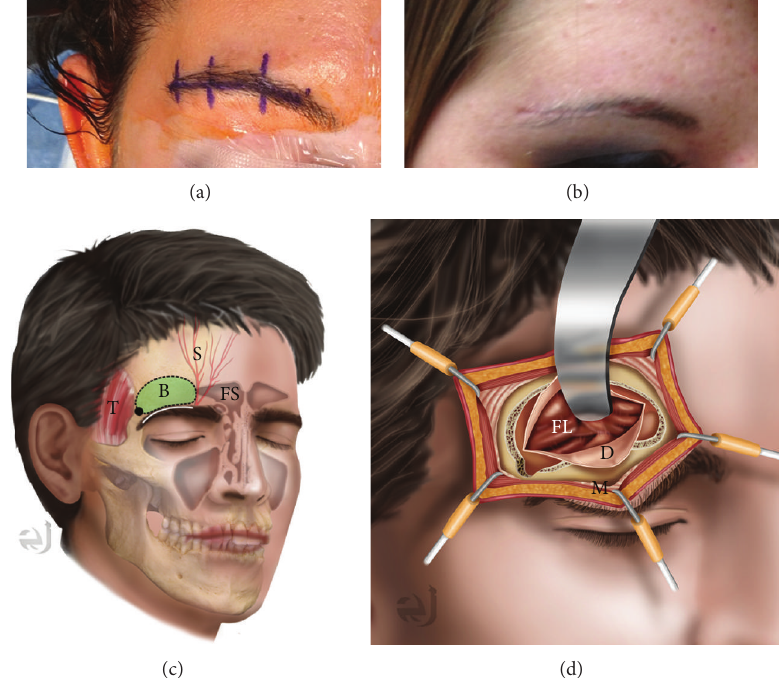
Figure 4: (a) Preoperative image of planned right eyebrow incision and (b) six-week postoperative image in the same patient. (c) Illustration of supraorbital craniotomy through an eyebrow incision. The incision is within the eyebrow (white), lateral to the supraorbital nerve (S) and frontal sinus (FS). The temporalis (T) is separated just posterior to the zygomatic process for the burr hole. Bone flap is approximately 1.5 × 2 cm (B). (d) Illustration after opening demonstrating dural opening (D), retracted frontal lobe (FL). The orbicularis oculi muscle (M) is reflected inferiorly with the